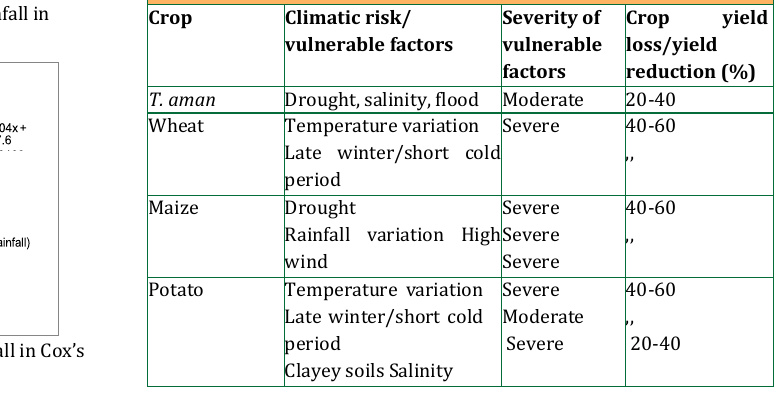
Table 2: Impacts of different climatic risk factors on crop